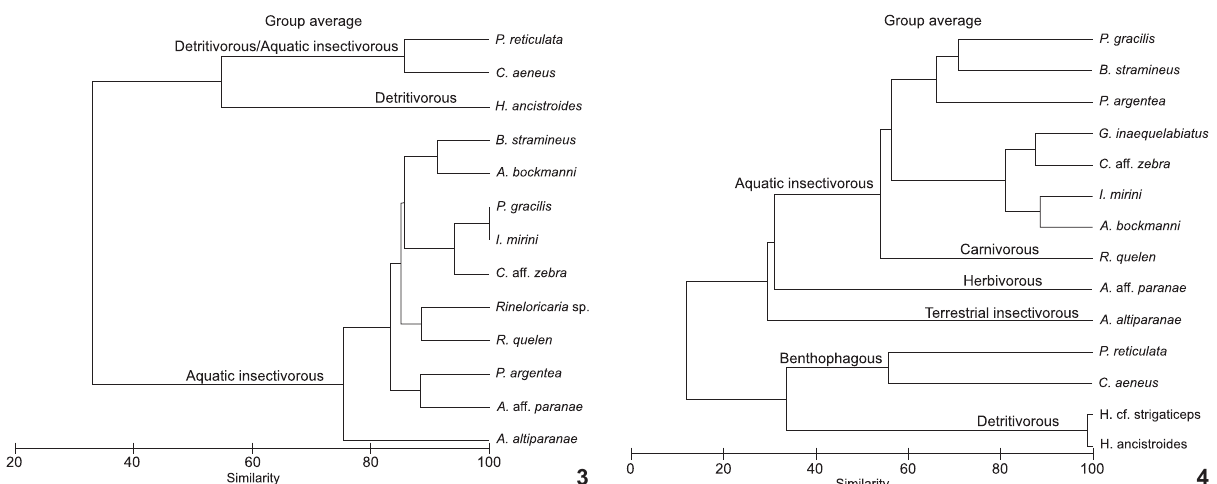
Figures 3-4. Similarity dendrogram based on the diet composition of the fifteen species of fish analyzed in (3) Morangueiro and (4) Queçaba streams, PR,